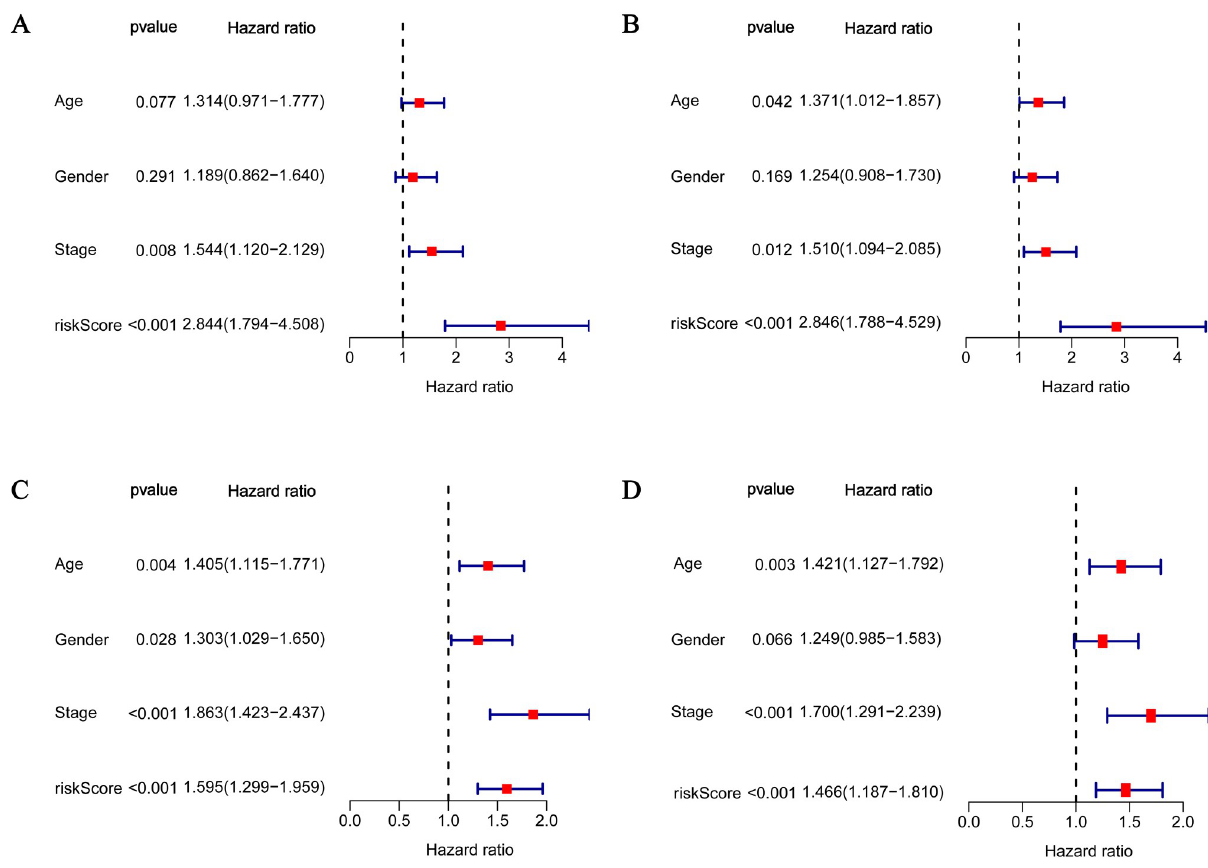
Fig 6. Results of the univariate and multivariate Cox regression analyses regarding OS in the TCGA cohort (A, B) and the GEO cohort (C, D).